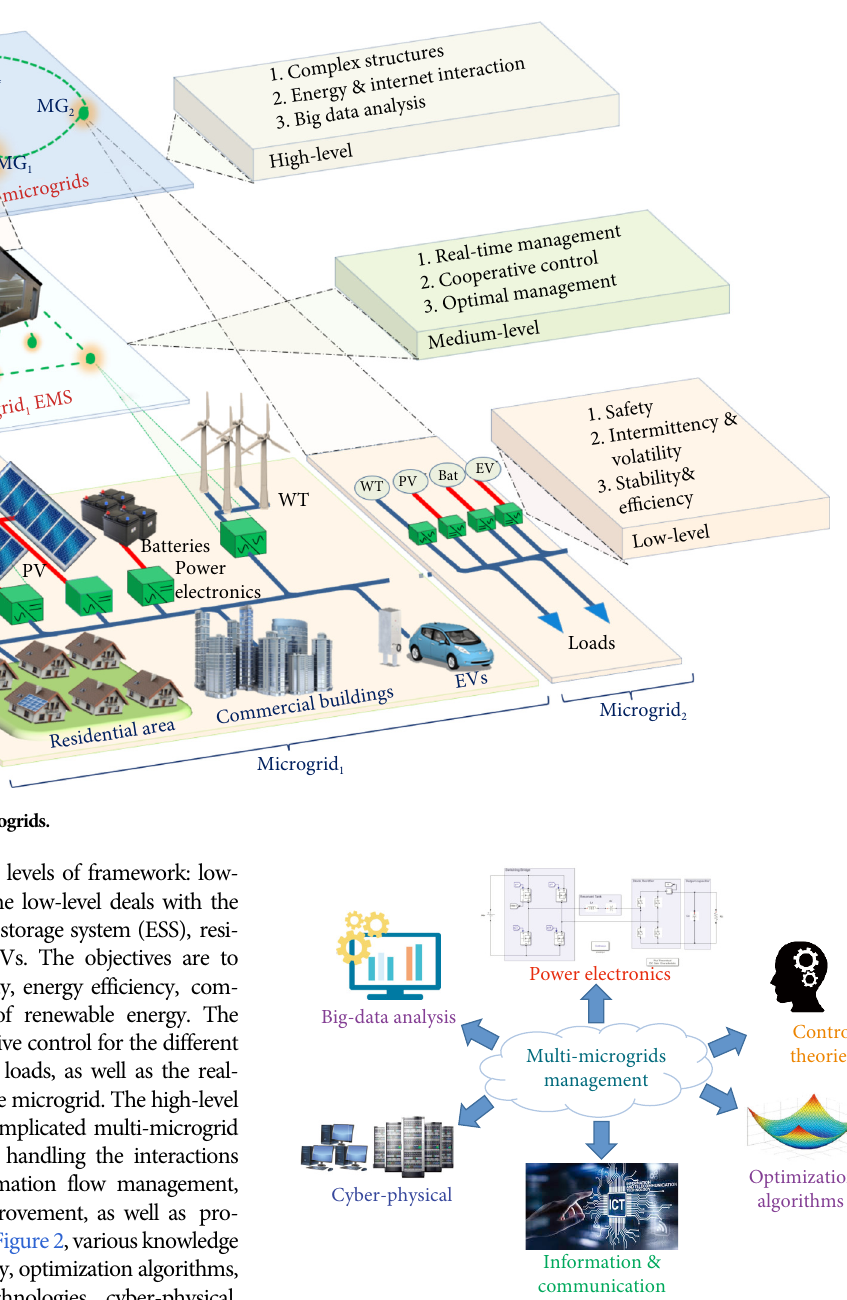
Fig. 2 The needed knowledge for